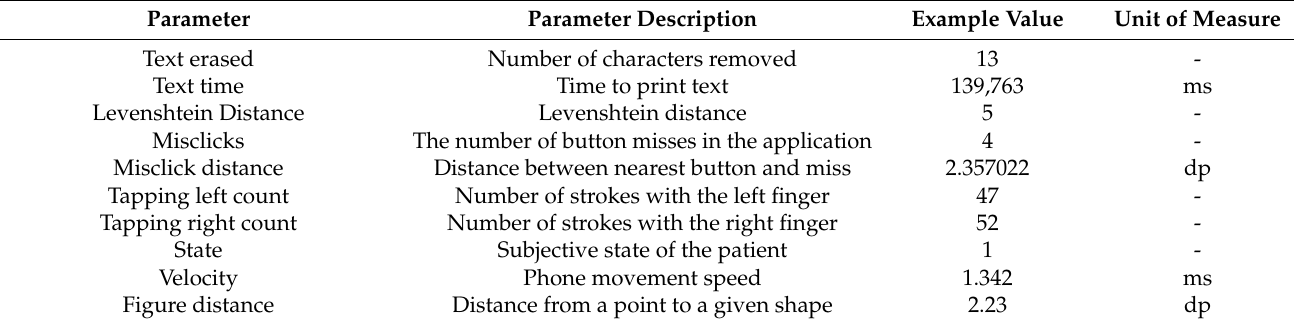
Table 1. An example of input data for building a neural network based on patient testing